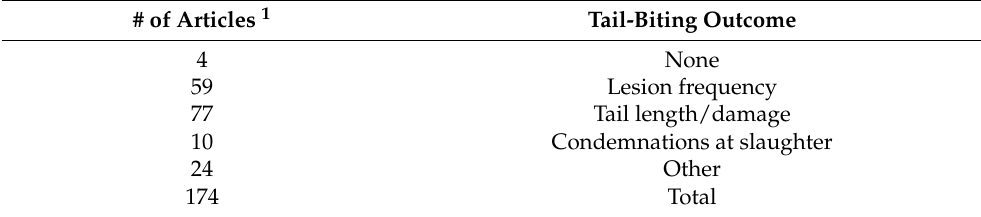
Table 4. Number of articles and the categories of tail-biting (TB) outcome measured. # of Articles 1